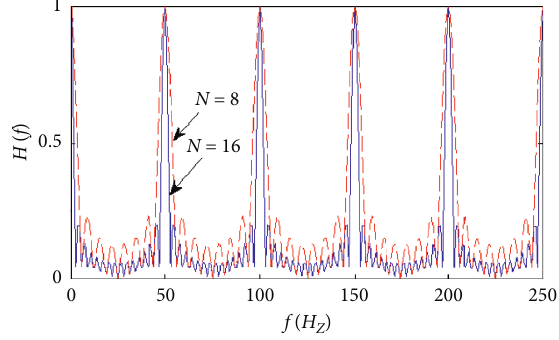
Figure 10: Amplitude-frequency response of